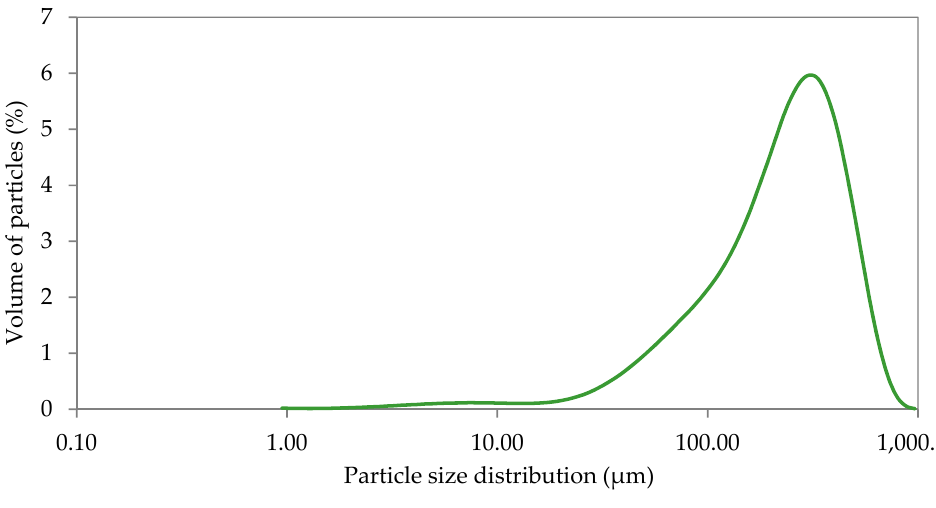
Figure 1. Particle size distribution of SAP. The cellulose fibers came from the CIUR a.s. Company, (Brand ý s and Labem, Czech Republic). The fiber lengths ranged between 2 and 4 mm. Information about the used